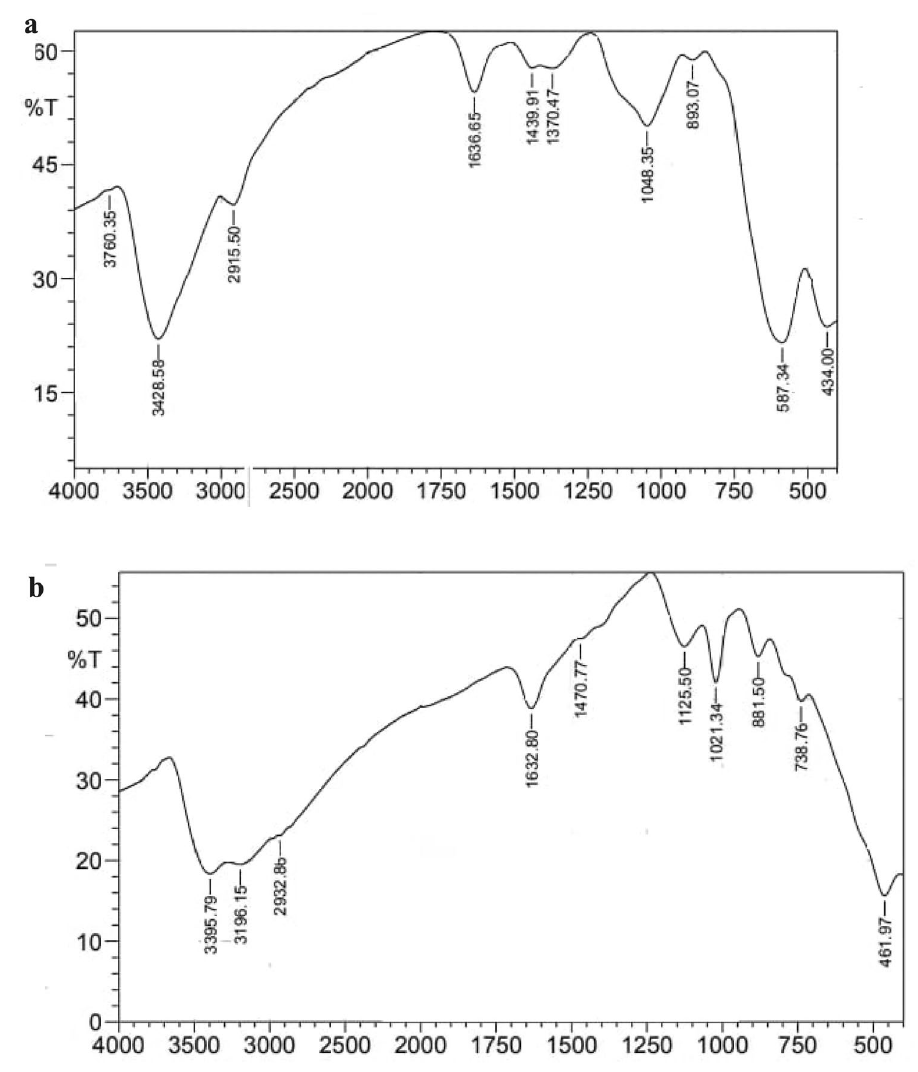
Fig. 12 FTIR of the formed flocs by EC technique a